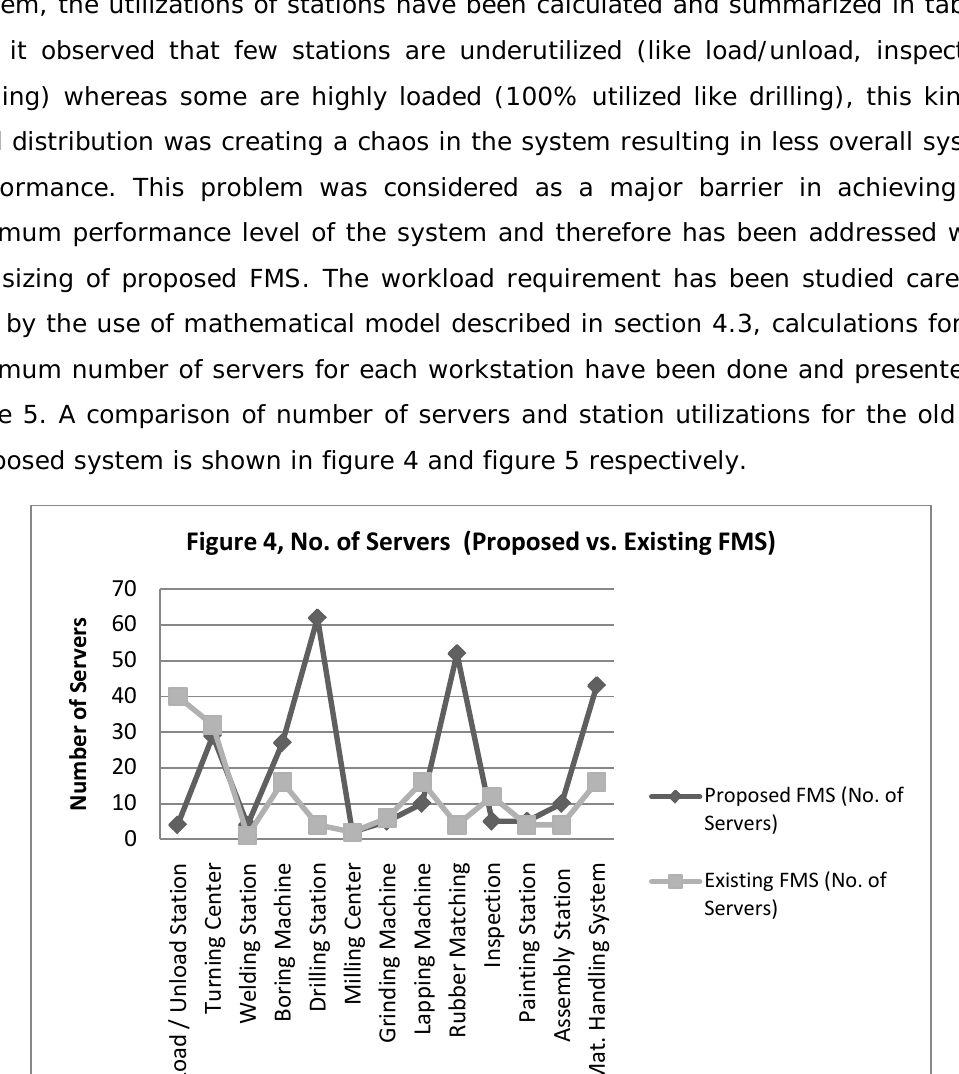
Proposed FMS (No. of Servers) Existing FMS (No. of